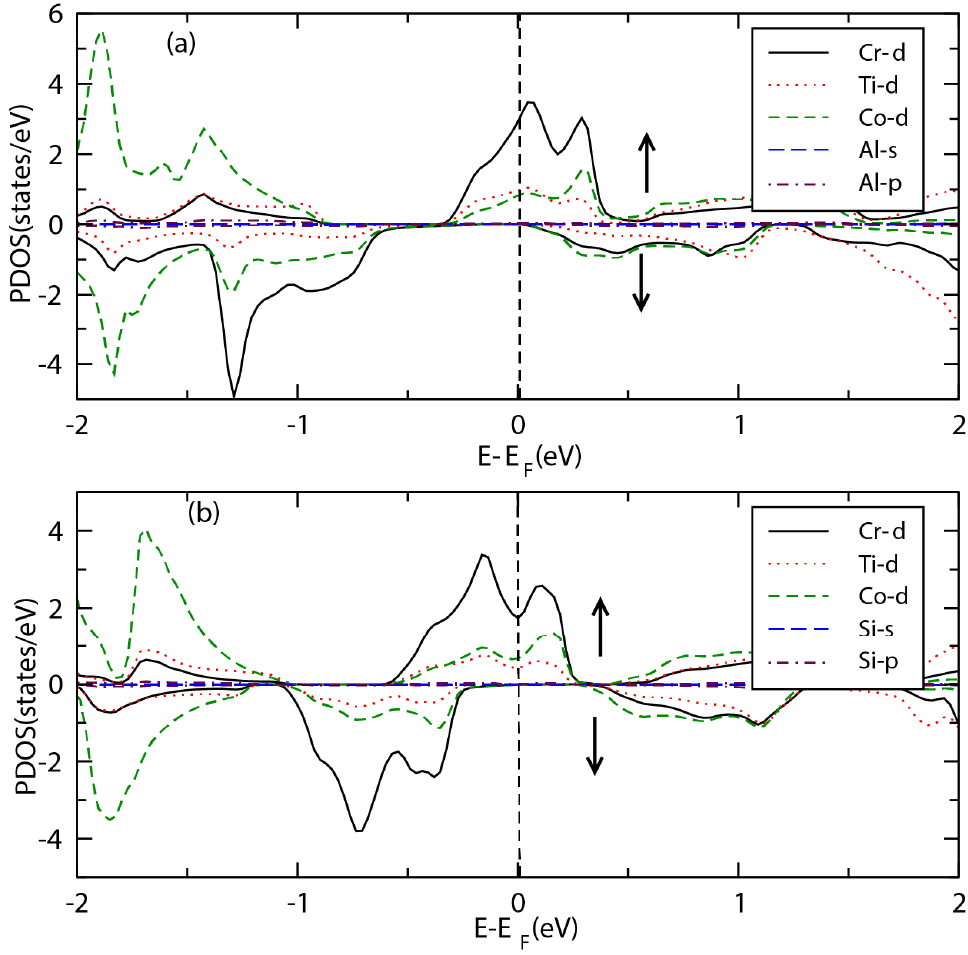
Figure 5. Projected density of states (PDOS) showing the contribution from different atomic orbitals for ( a ) CrTiCoAl and ( b ) CrTiCoSi compounds.